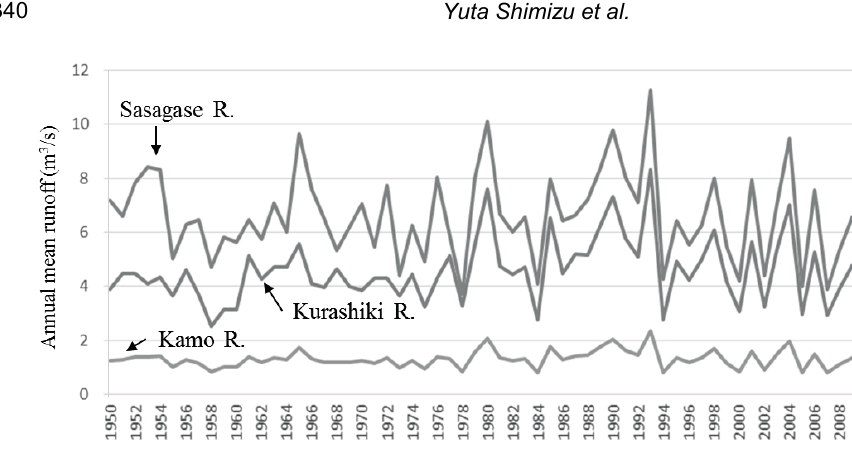
Fig. 2 Estimated annual mean runoff.